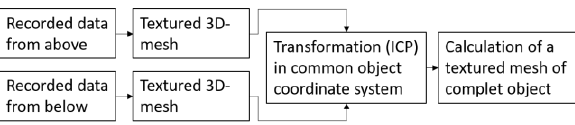
Figure 8. Processing workflow with VXelements.